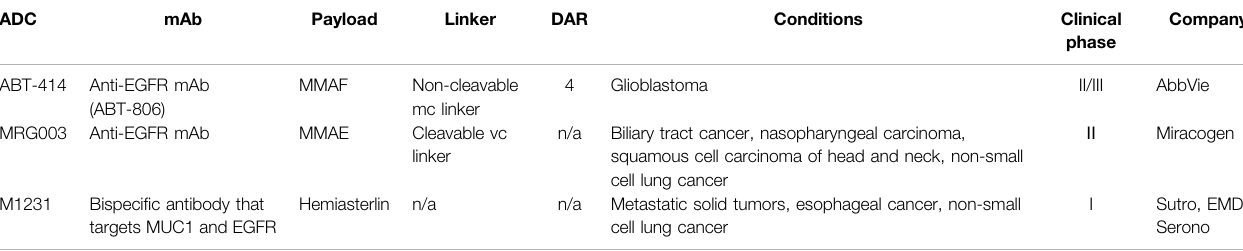
TABLE 1 | Summary of anti-EGFR ADCs in clinical investigation.